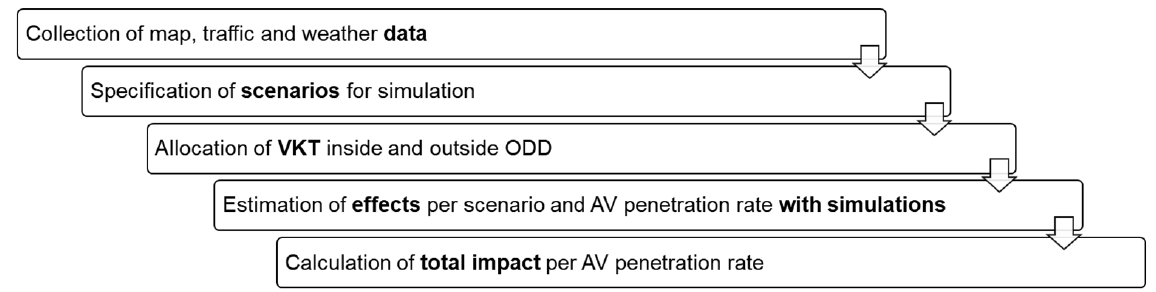
Figure 2. Determining the impacts of motorway ADF at European level. (VKT: vehicle kilometres travelled, ODD: operational design domain, AV: vehicles equipped with an automated driving